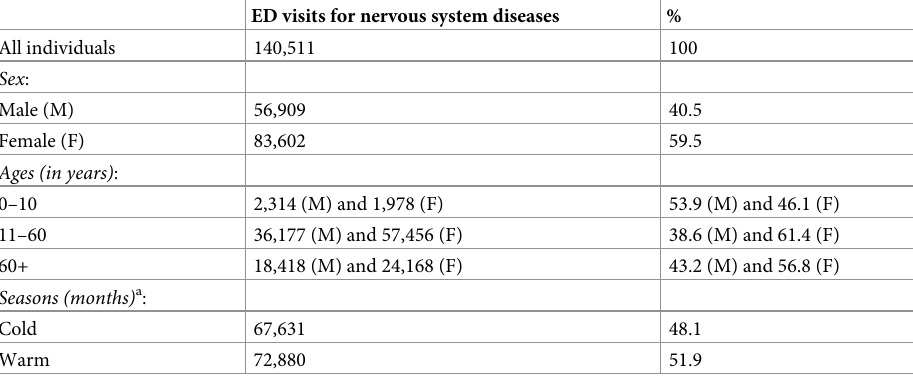
Table 1. Descriptive statistics on the number of ED visits for diseases of the nervous system (ICD-10 codes: G00 – G99) collected in the city of Toronto between April 1, 2004 and December 31, 2015. ED visits for nervous system diseases